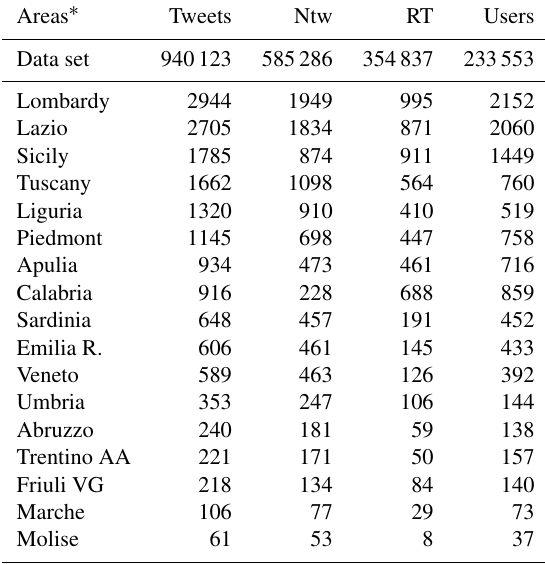
Table 1. Main features of the data